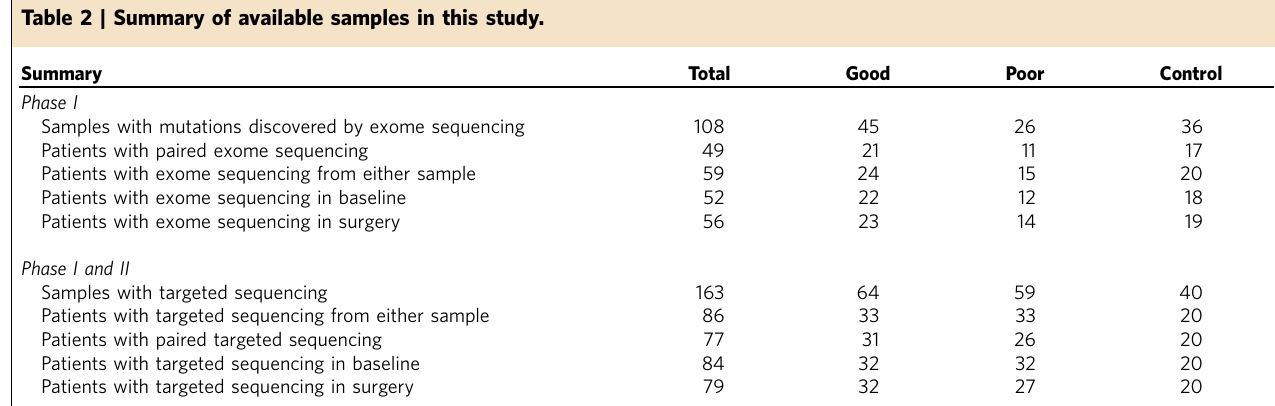
Table 2 | Summary of available samples in this